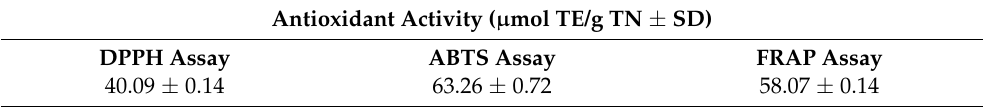
Table 3. Antioxidant activity of Thinned Nectarine extracts evaluated by DPPH, ABTS and FRAP